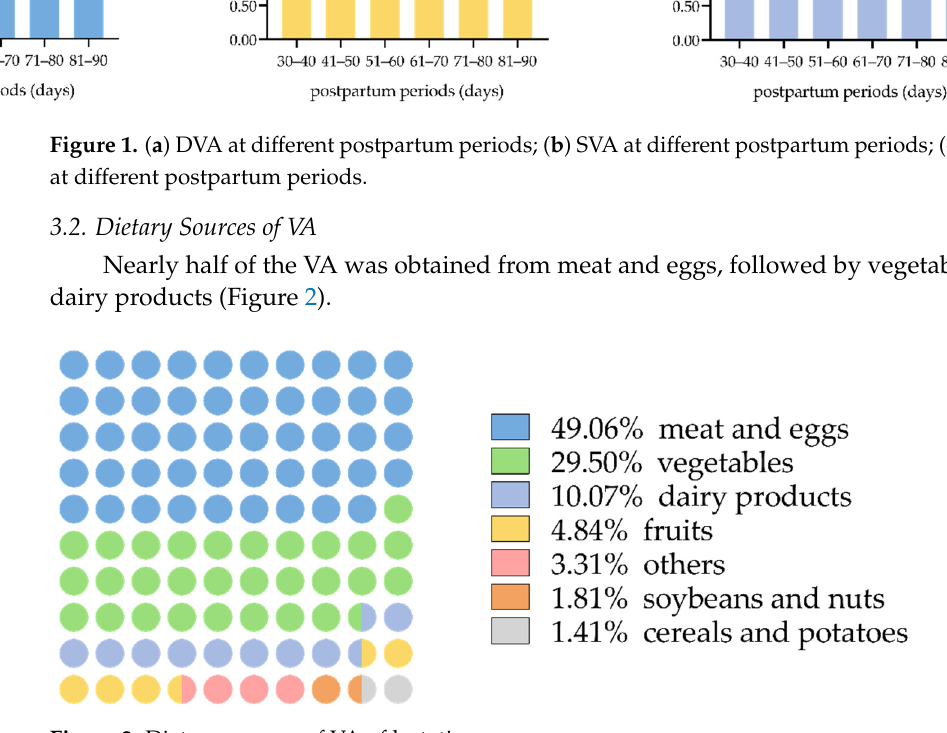
Figure 2. Dietary sources of VA of lactating women.